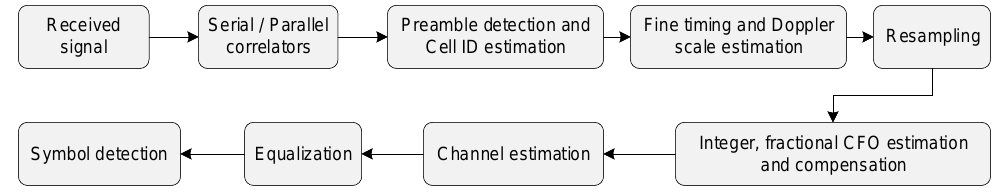
Figure 1. Typical receiver processing modules for OFDM-based underwater communication